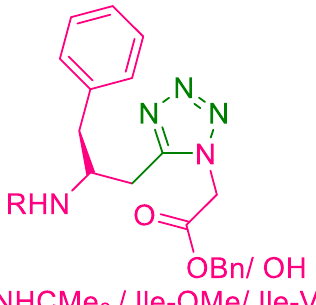
Figure 14. Tetrazole-based peptidomimetics.